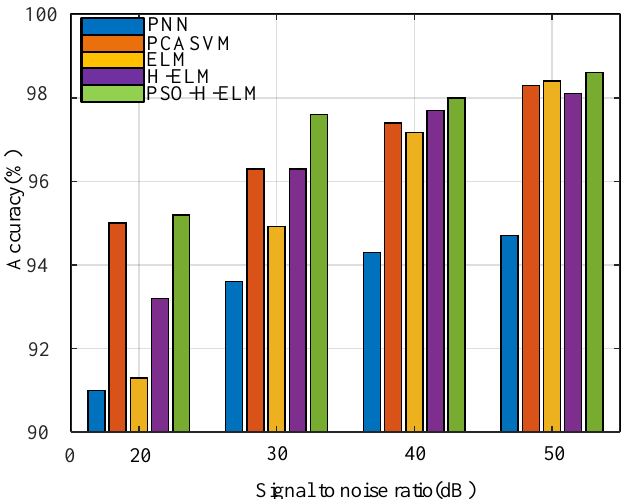
Figure 4. Five methods of classification accuracy rate histogram. PCAVSM—principal component analysis and support vector machines.